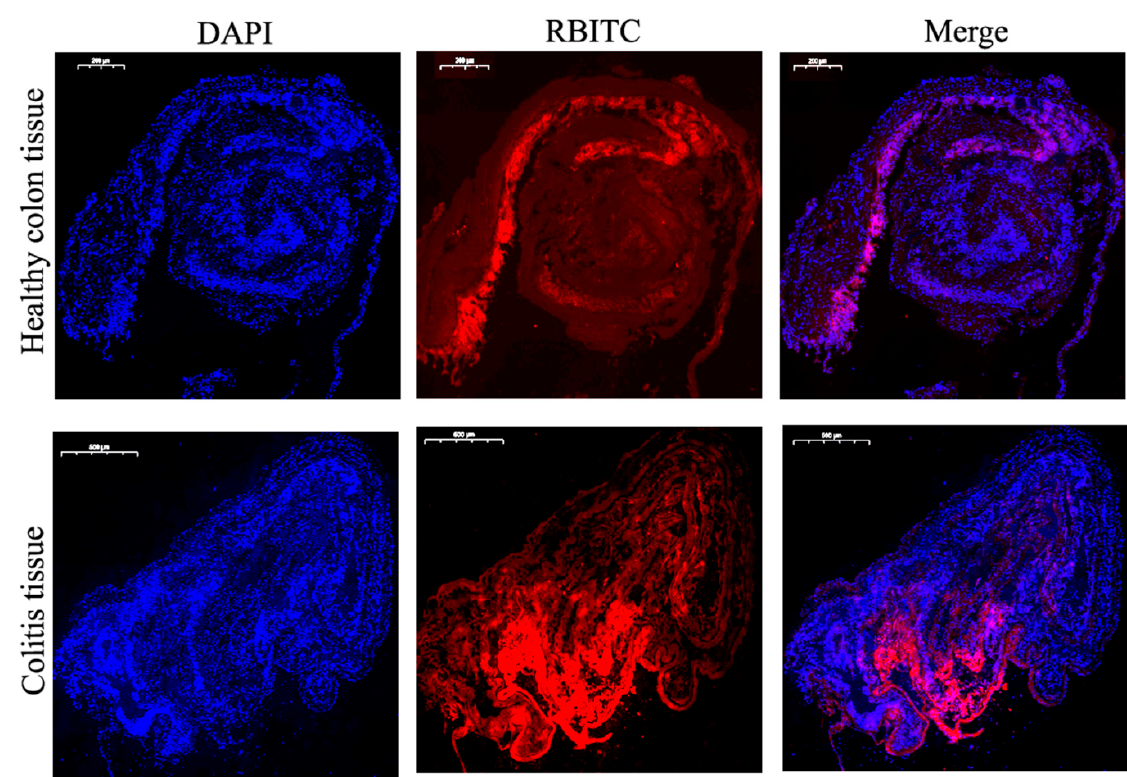
Figure 8. The uptake of NPs by colon tissues after 6 h of co-incubation. Healthy colon tissue and colitis tissue treated with RES-PCAC-NPs (red) and sliced, and fluorescent staining performed. The fixed tissue was stained with DAPI to observe the cell nucleus (blue).